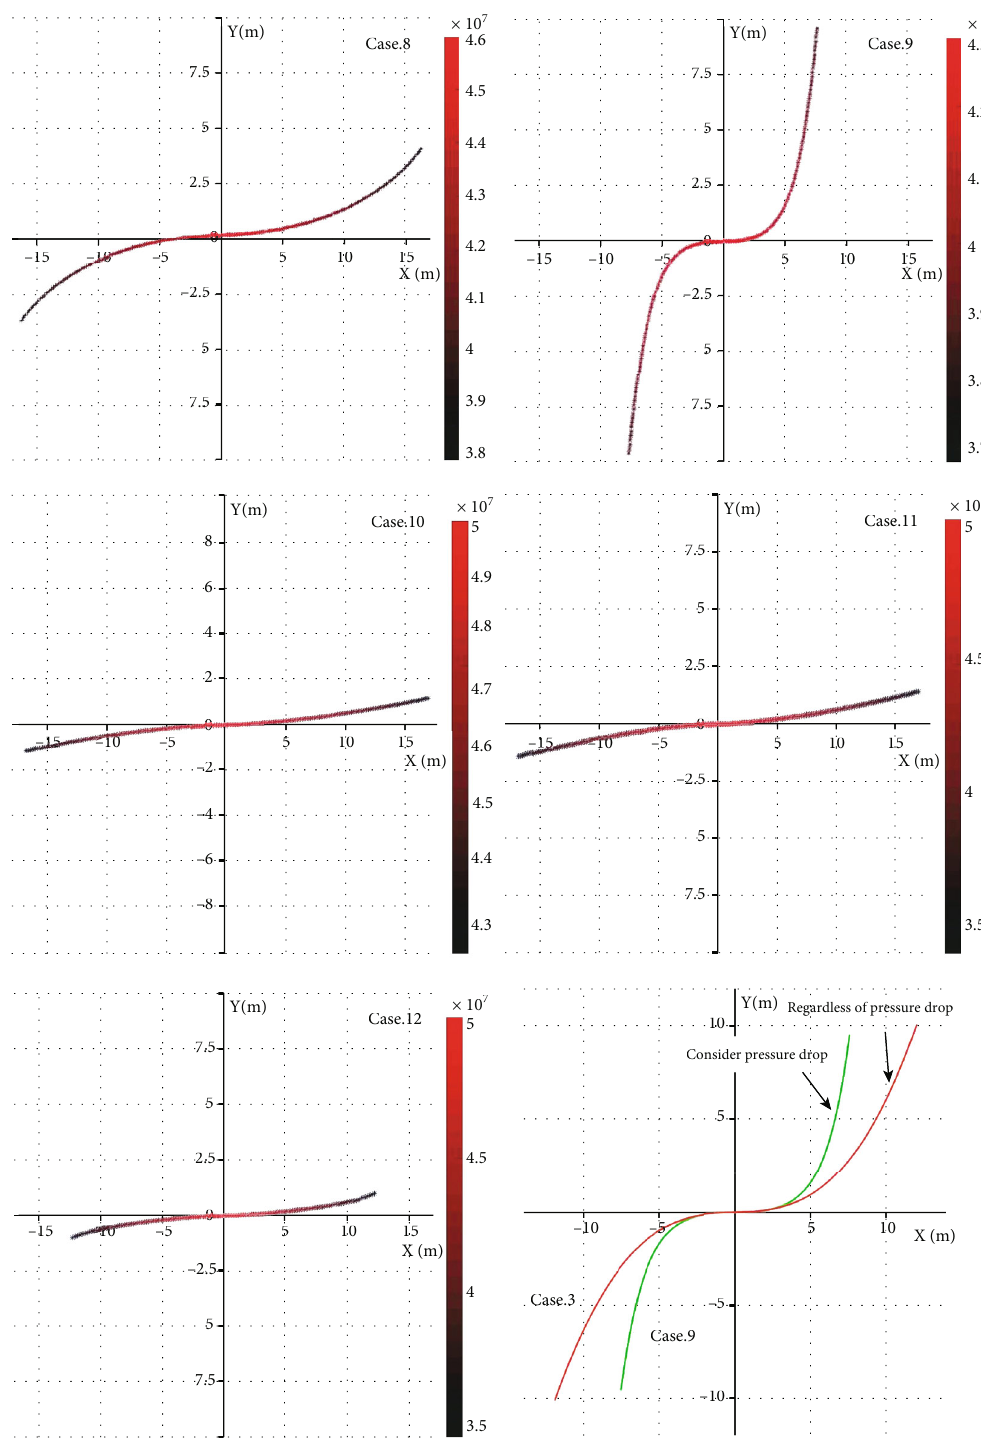
Figure 8: HF morphology when considering the drop of fl uid pressure in the HF.